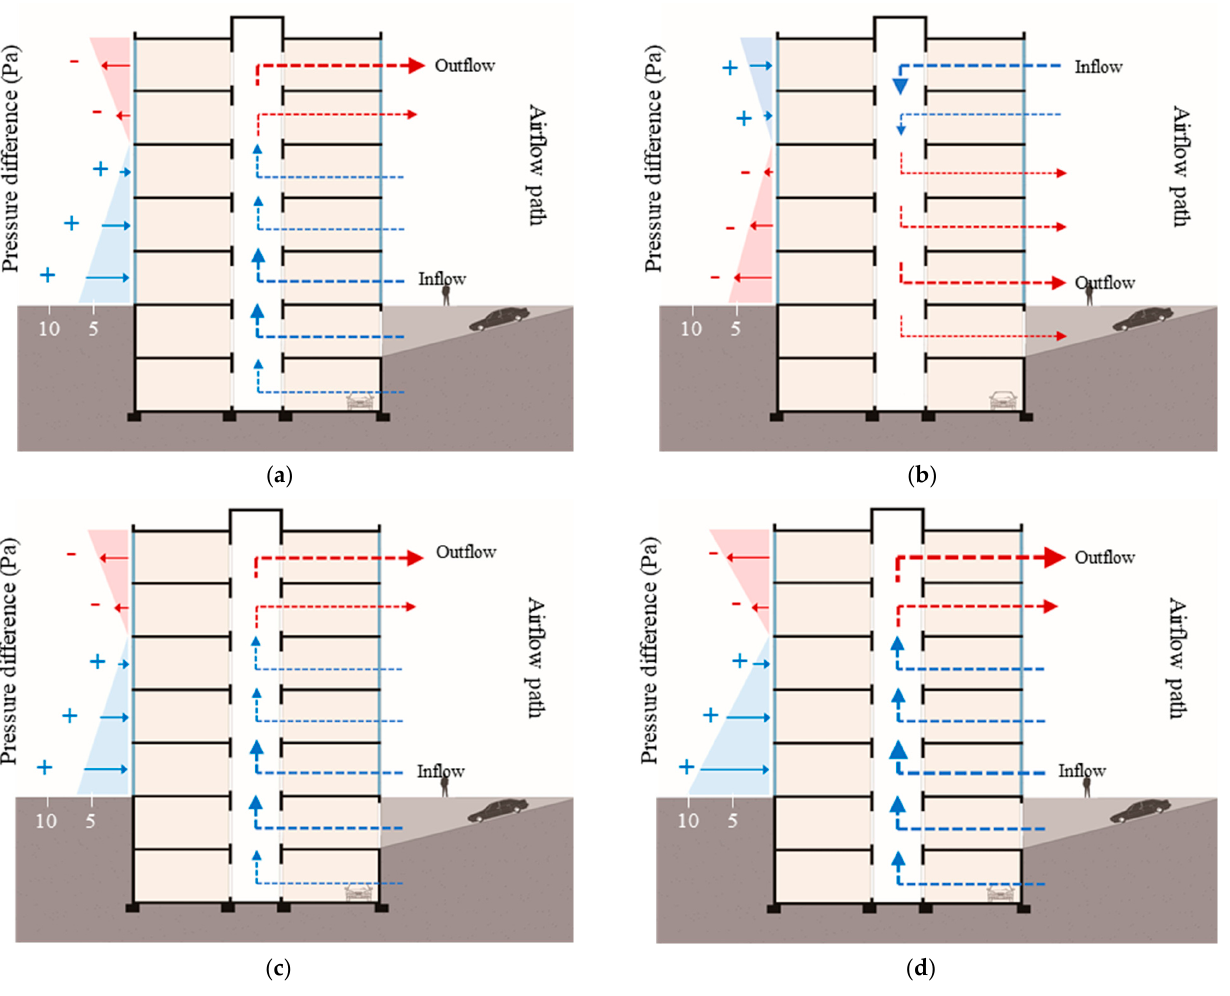
Figure 7. Pressure distribution and airflow path in the reference building: ( a ) case 1, spring; ( b ) case 2, summer; ( c ) case 3, autumn; ( d ) case 4, winter.